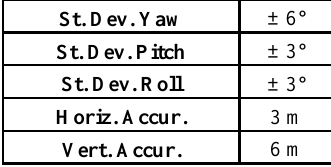
Table 2 Estimated performance of the embedded